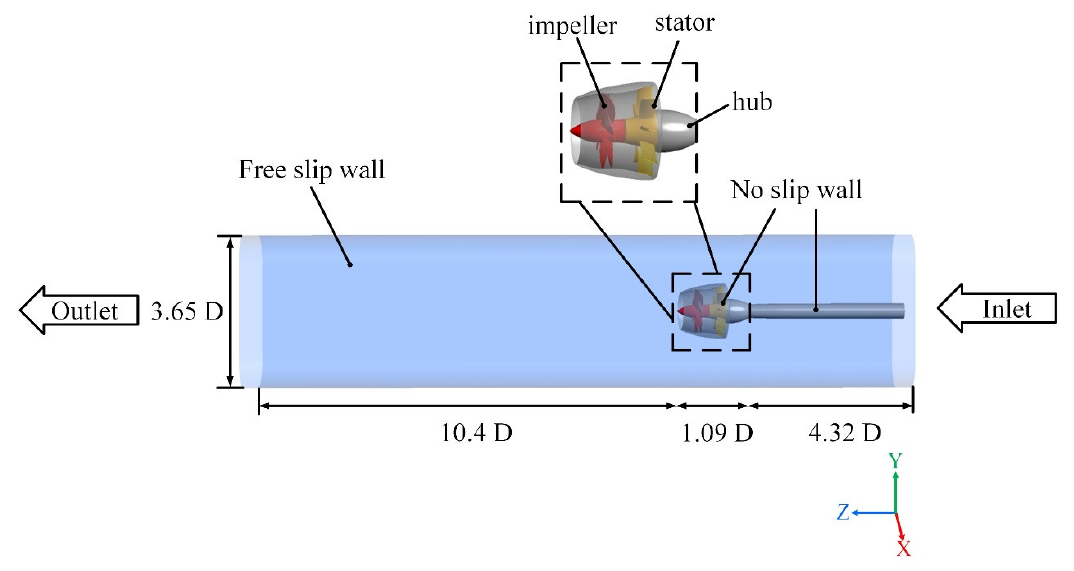
Figure 1. Simulation-domain and boundary conditions.